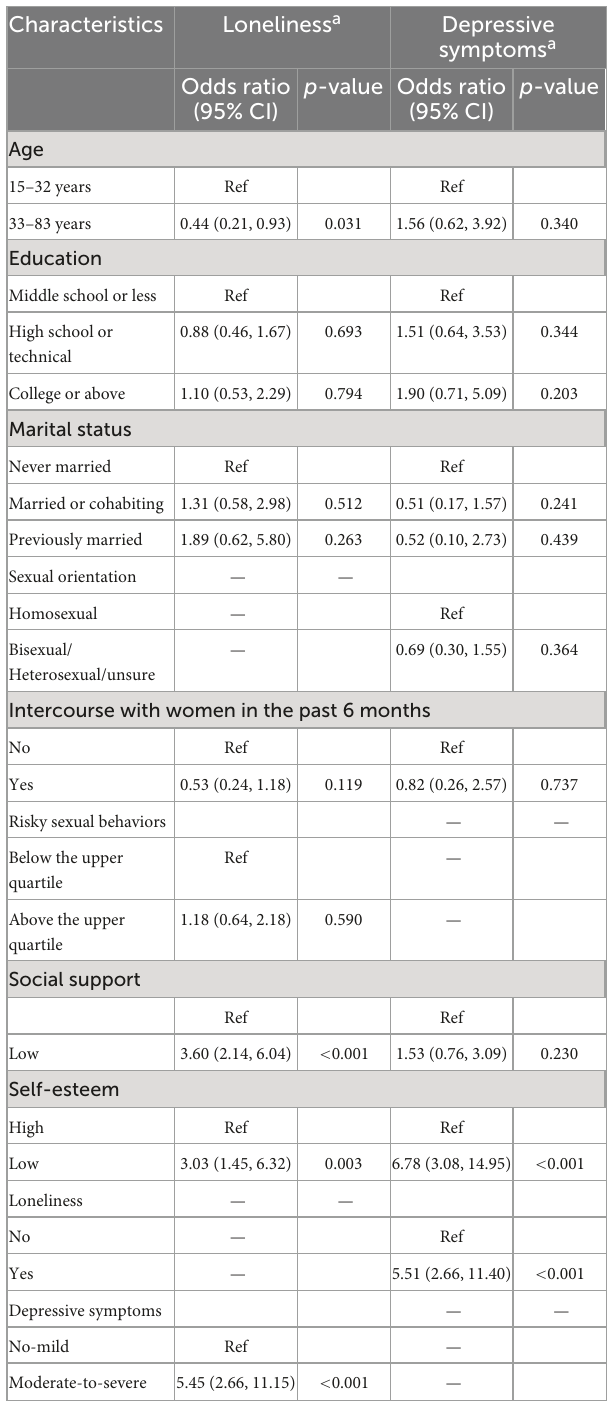
TABLE 2 Multivariable logistic regression models of the factors associated with loneliness and depressive symptoms.